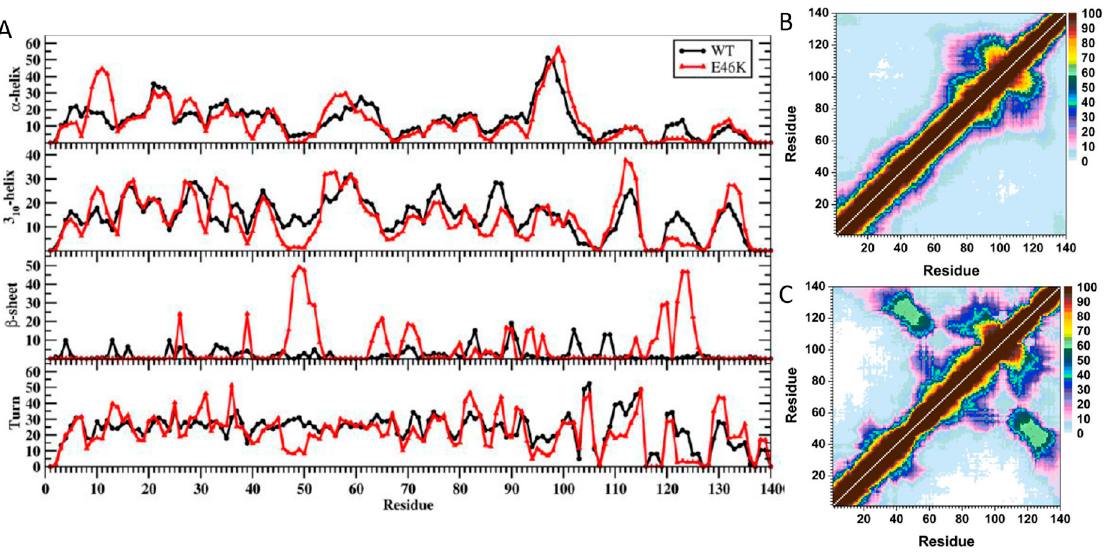
Figure 2. ( A ) WT and E46K α S secondary structure components. Secondary structure abundances per residue for the WT (black) and E46K mutant (red) α S. The abundances for the π -helix and coil structures are not displayed; ( B , C ) WT and E46K α S tertiary structures. Calculated intramolecular interactions of the WT (WT) and the E46K mutant type (E46K) α S. The color scale corresponds to the probability (P) of the distance between the heavy atoms (C, N, O, S) of a residue being ≤ 20 Å from each other.